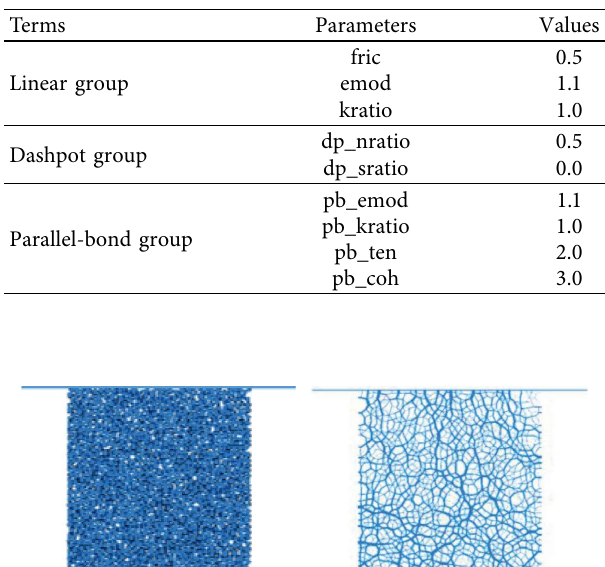
Table 1: Meso-mechanical parameters of the backfll.